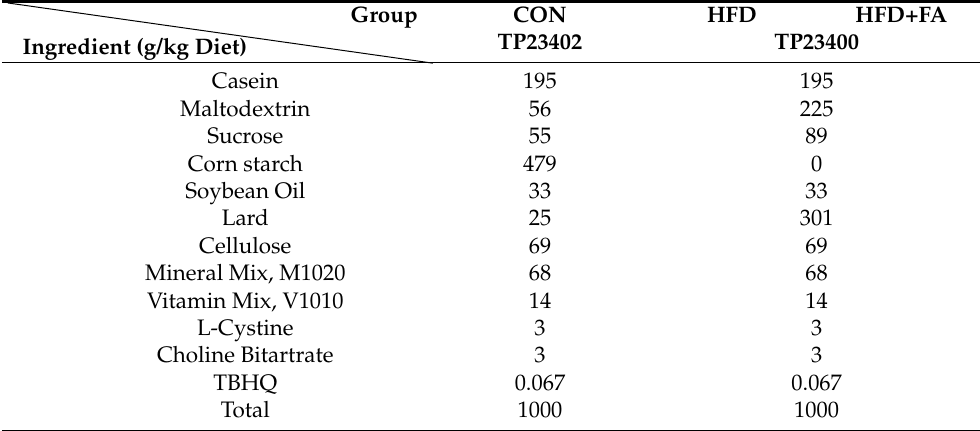
Table 2. Ingredient composition of experimental